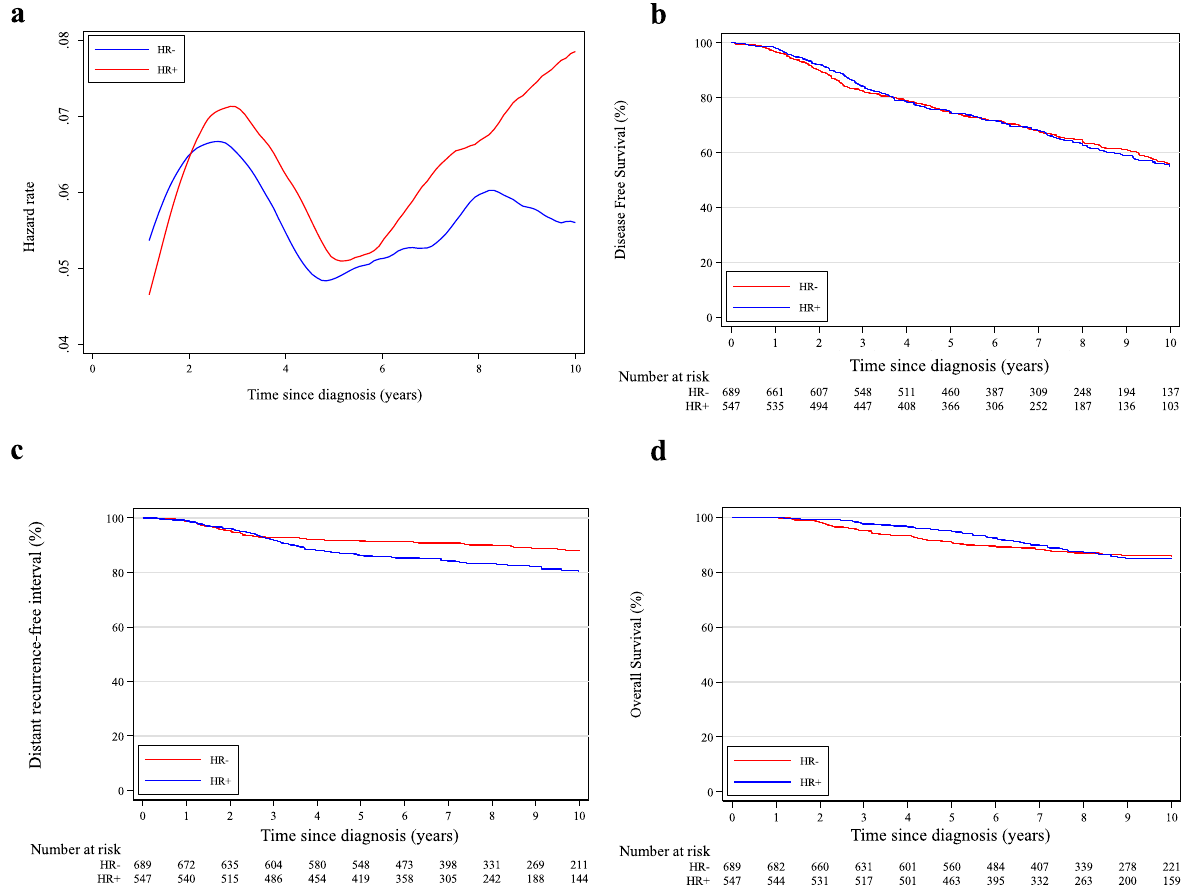
Fig. 4 Comparison between patients with hormone receptor-positive and negative disease. a Epanechnikov Kernel-Smoothed annual hazards of recurrence overall; b Disease-free survival; c Distant recurrence-free interval; d Overall survival. HR + hormone receptor-positive; HR − hormone